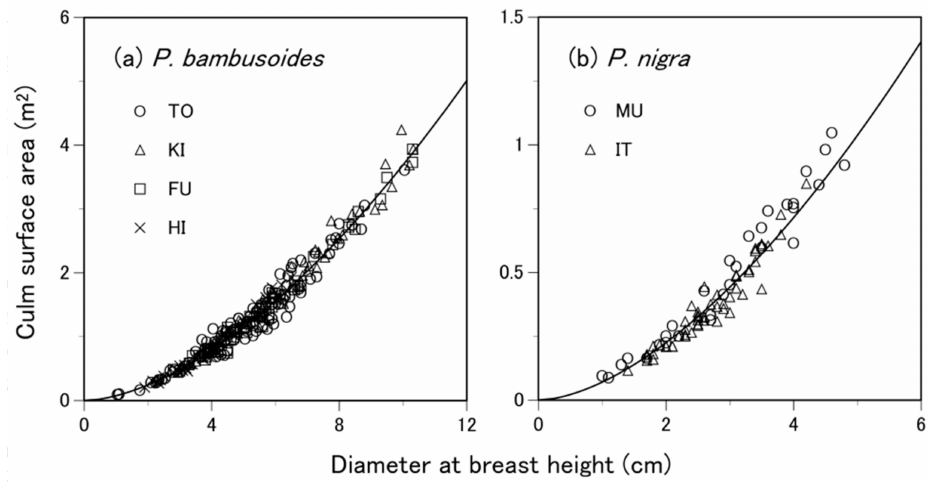
Figure 3. Relationship between culm surface area and diameter at breast height in ( a ) Phyllostachys bambusoides and ( b ) P. nigra . The solid lines represent the power equations detailed in Table 3.